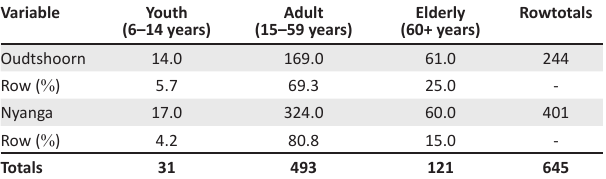
FIGURE 1: Percentage of total reported to have different levels of disability severity. TABLE 6: Disability prevalence by age.